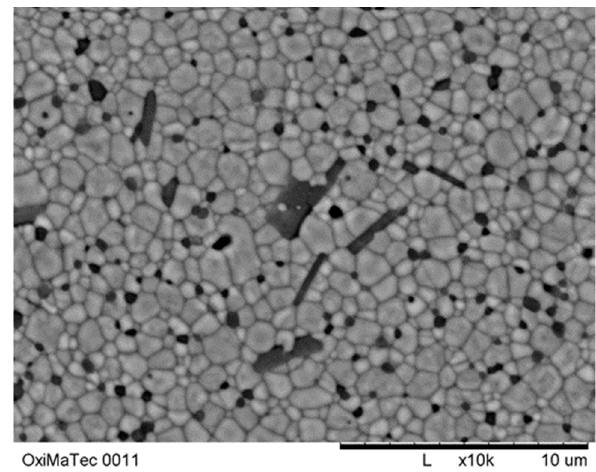
Figure 38. Microstructure of preliminary Y-Ce-TZP/Al 2 O 3 /LaAl 11 O 18 .